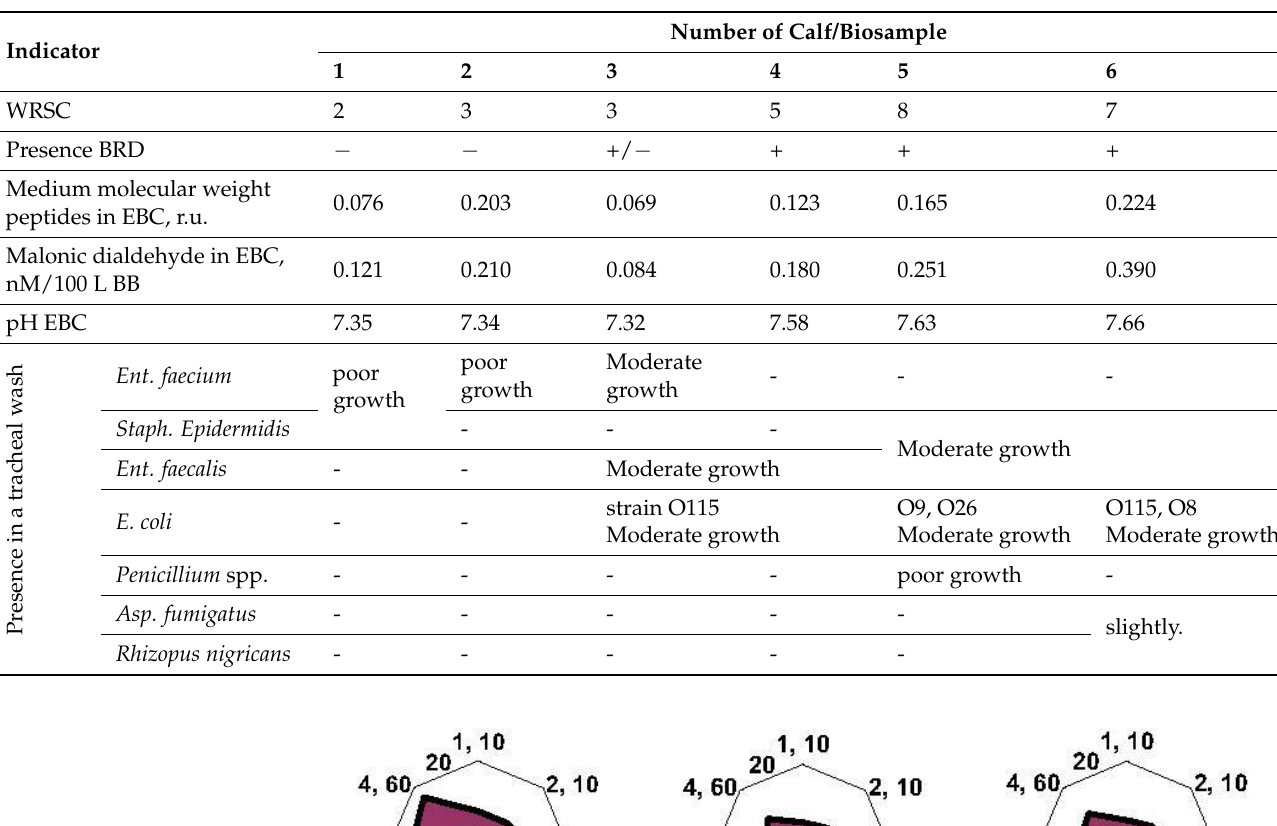
Table 14. Results of clinical examination and biochemical analysis of exhaled breath condensate samples of calves.